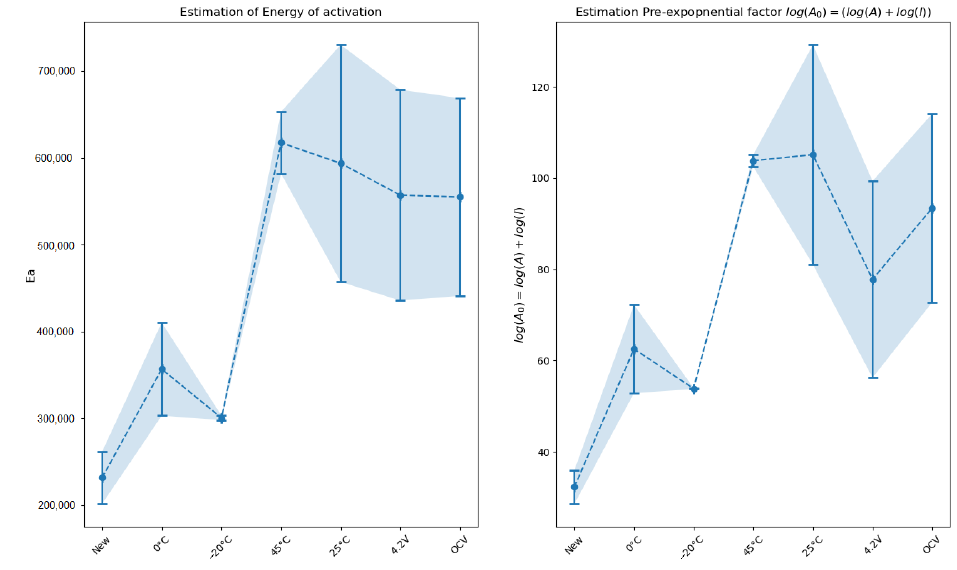
Figure 9. E a and pre-exponential factor A 0 for different ageing